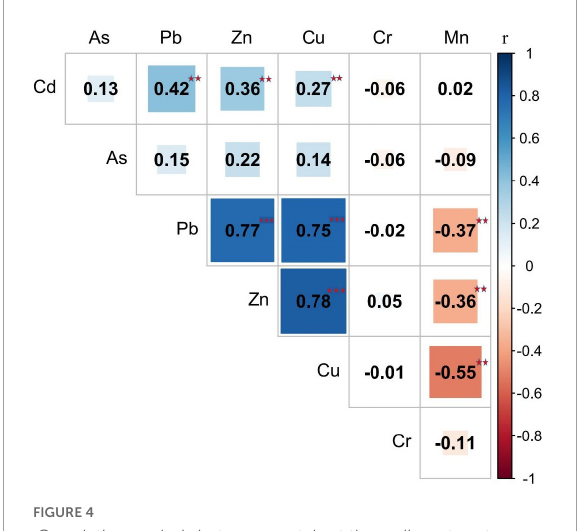
FIGURE4 .Correlation analysis between metals at the sediment-water interface of Chagan Lake during the ice-covered period. **Represents P < 0.01, ***represents P < 0.001.